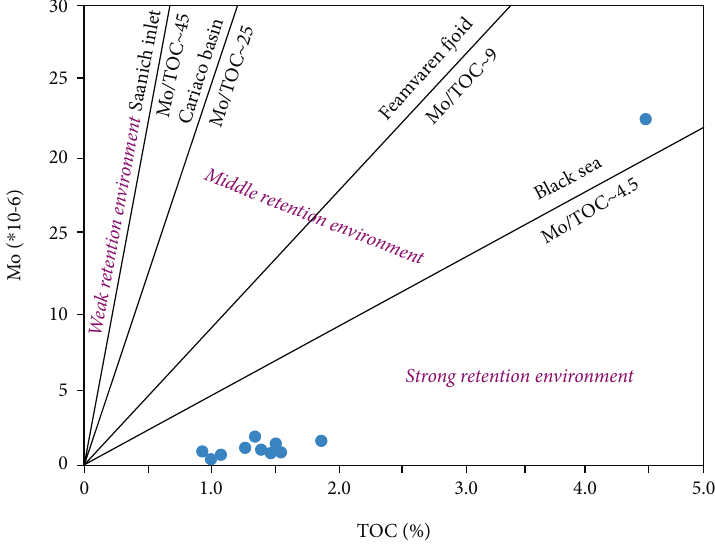
Figure 4: The relationship between Mo and TOC of the fi rst member of Luzhai Formation in Rongshui area [31].